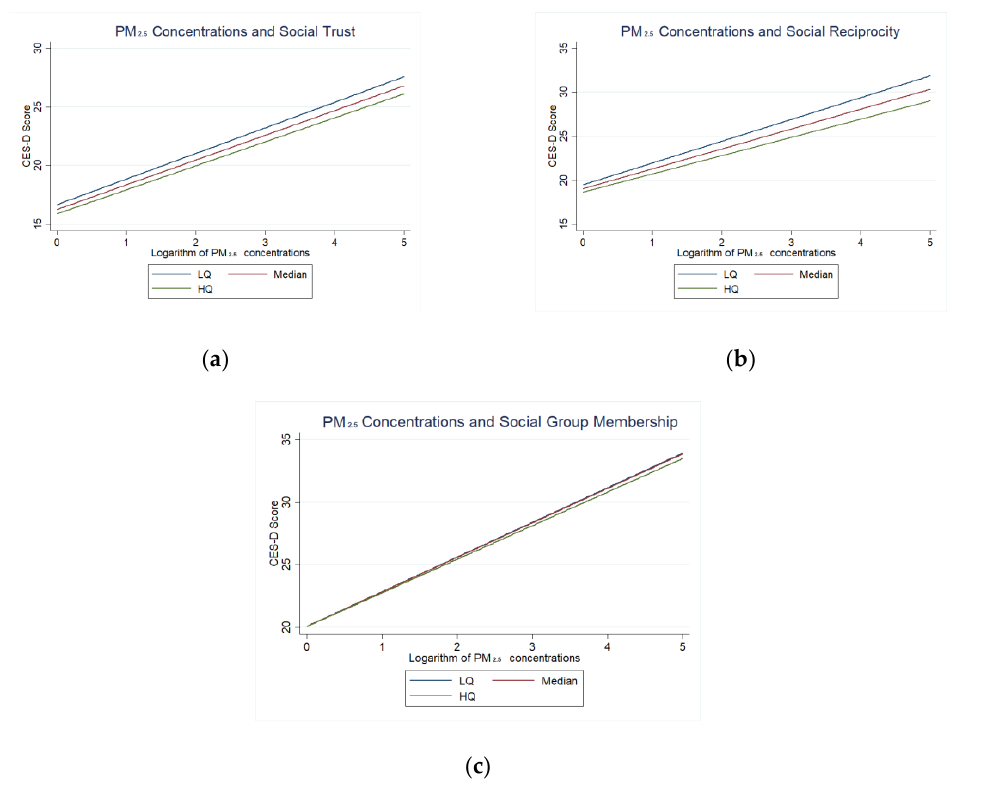
Figure 3. ( a ) Predicted relationship between PM 2.5 concentrations and CES-D scores differing by social trust; ( b ) Predicted relationship between PM 2.5 concentrations and CES-D scores differing by social reciprocity; ( c ) Predicted relationship between PM 2.5 concentrations and CES-D scores differing by social group membership.Lower Quartile (LQ = 25%), the median (MQ = 50%) and higher quartile (HQ = 75%).